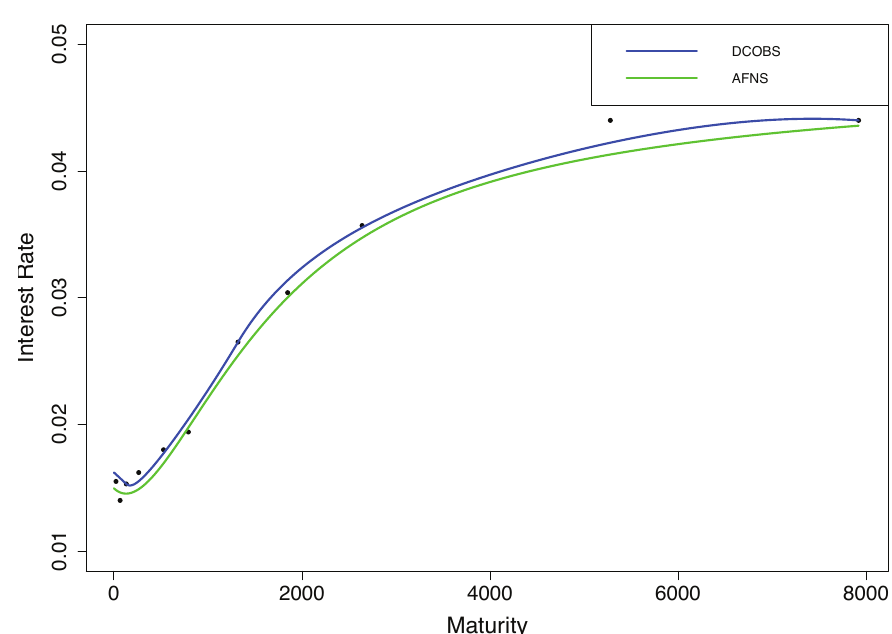
Figure 1. Dynamic Constrained B-Splines compared to Arbitrage-Free